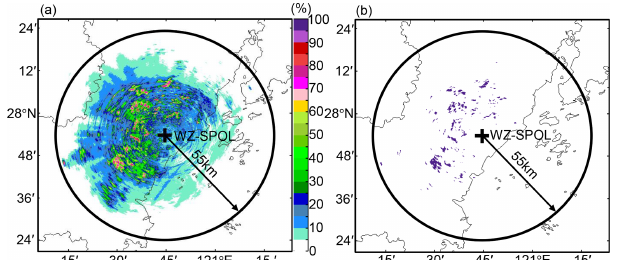
Figure 3. (a) Statistics of pixels with Z H > 0dBZ within 55km from the WZ-SPOL radar and (b) residual static ground clutter mask of the WZ-SPOL